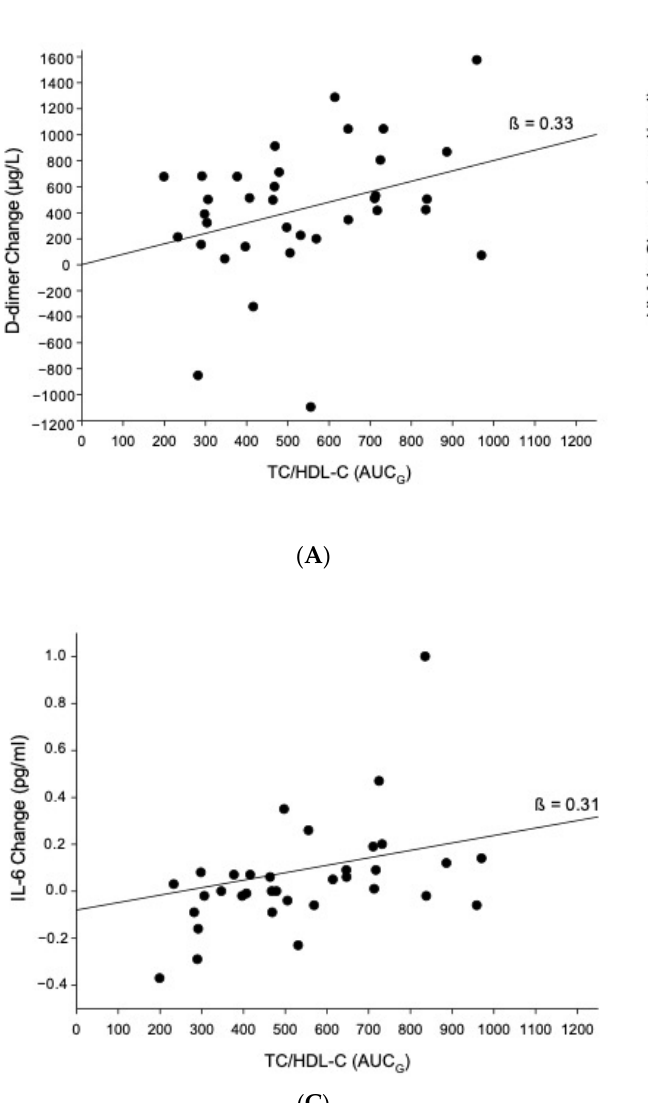
Figure 3. Higher aggregated TC/HDL-C stress reactivity (AUC G ) significantly predicted higher increases from baseline to follow-up in CVD risk factors: ( A ) D-dimer (ß = 0.33, p = 0.050, Δ R 2 = 0.11); ( B ) HbA1c (ß = 0.34, p = 0.046, Δ R 2 = 0.12); ( C ) IL-6 (ß = 0.31, p = 0.075, Δ R 2 = 0.09).